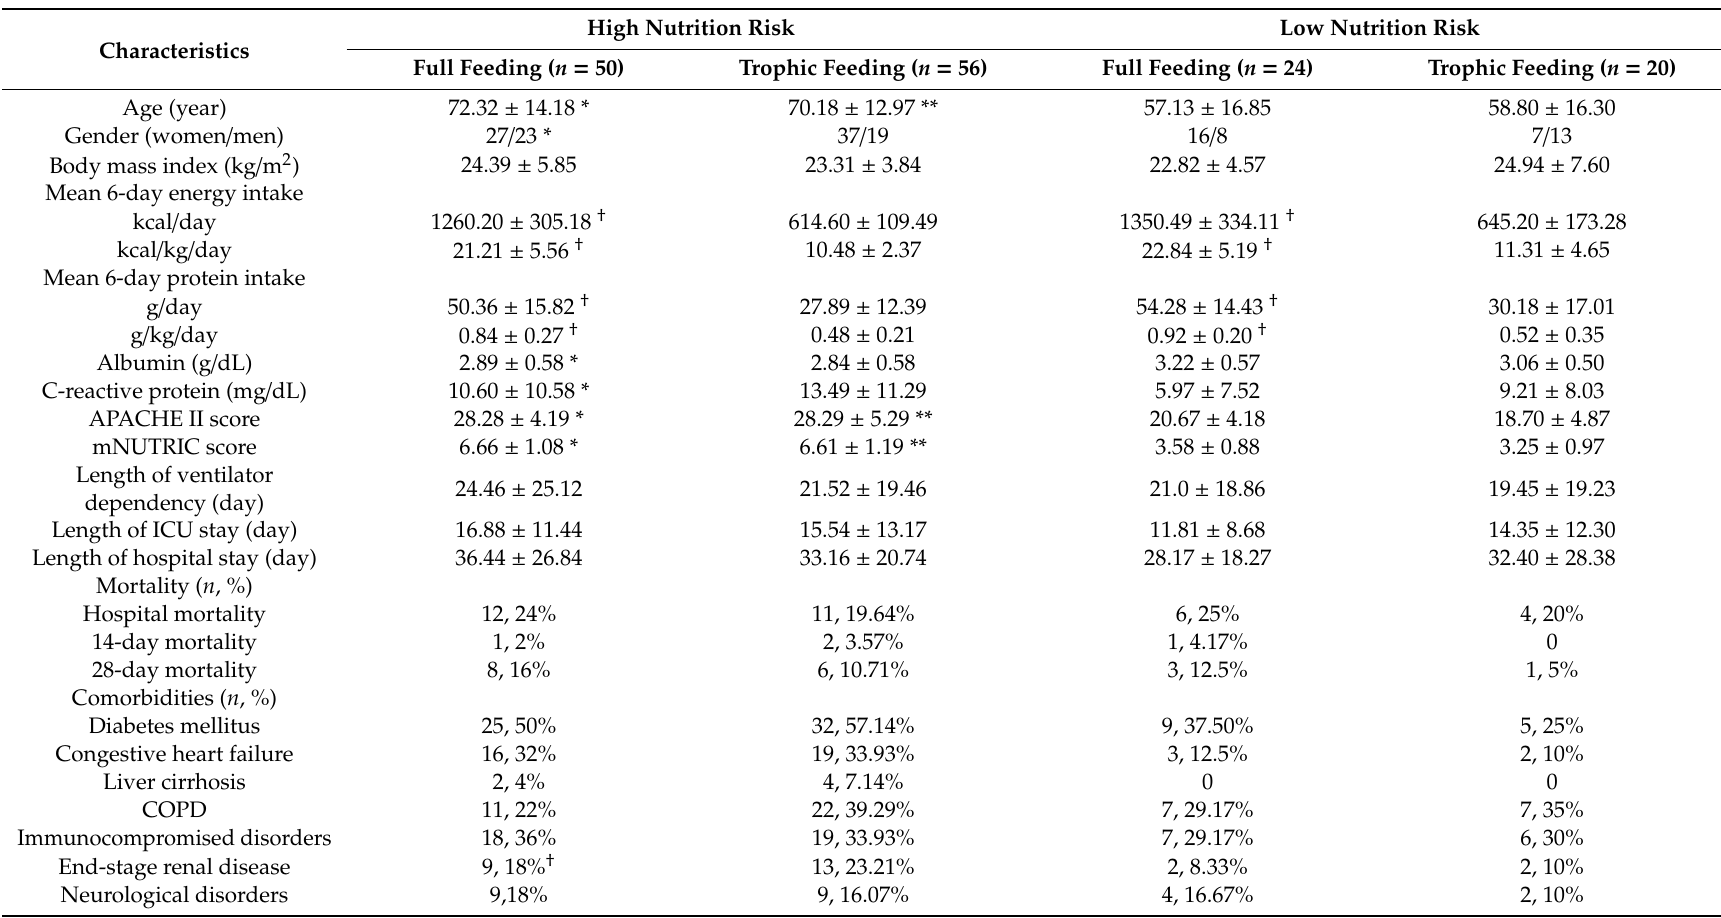
Table 1. Demographic and biochemical characteristics, clinical outcomes, and energy and protein intakes in high and low nutrition risk critically ill patients treated with full or trophic